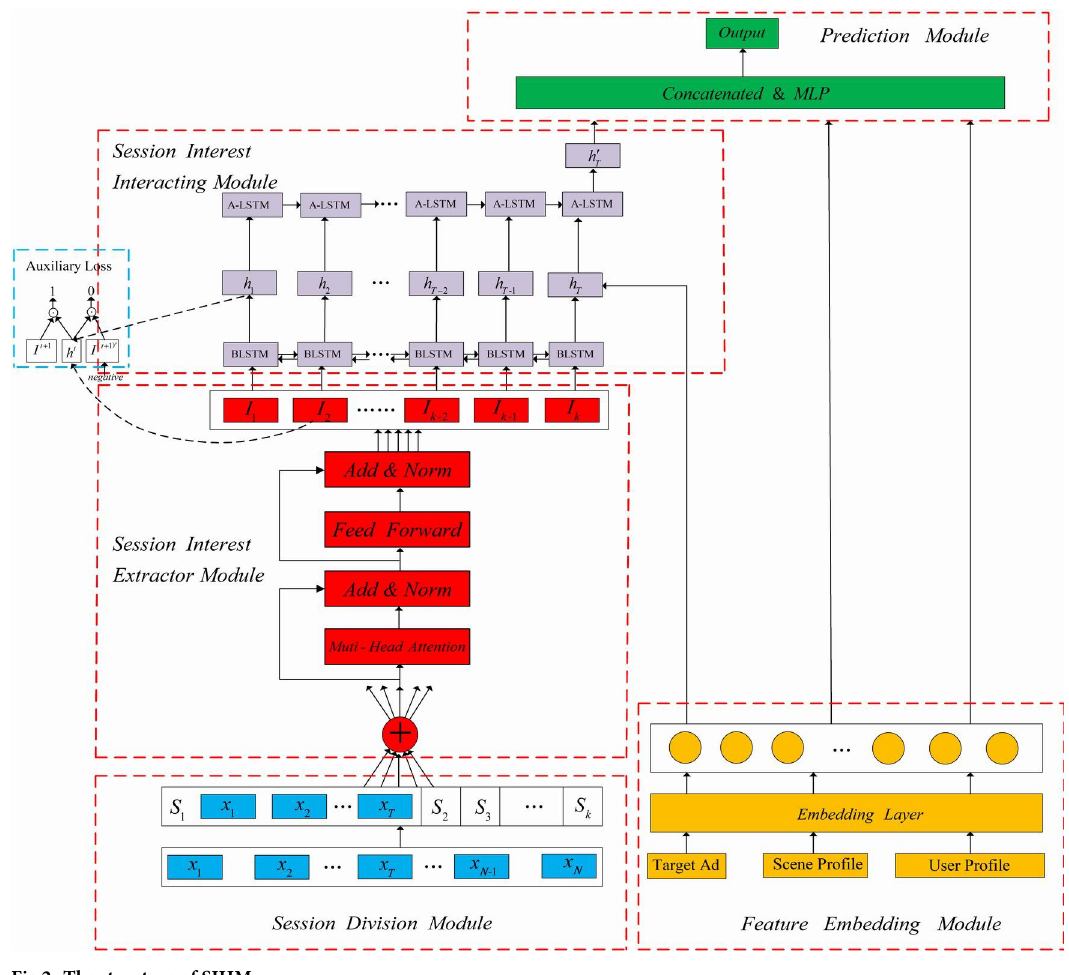
Fig 2. The structure of